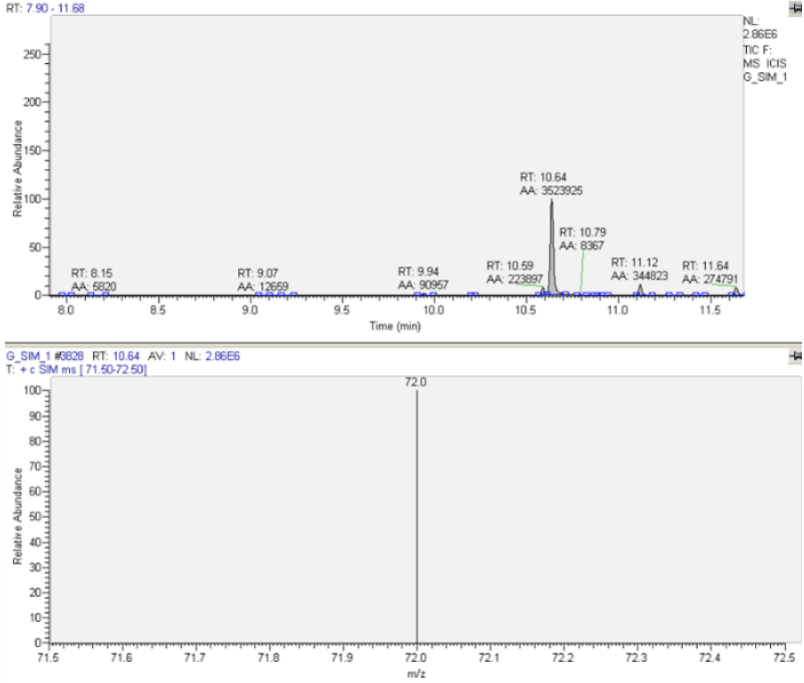
Figure 3. Typical chromatogram and MS spectrum for methadone determination in patients’ urine sample—SIM (t R = 10.64, m/z = 72), Patient 7.